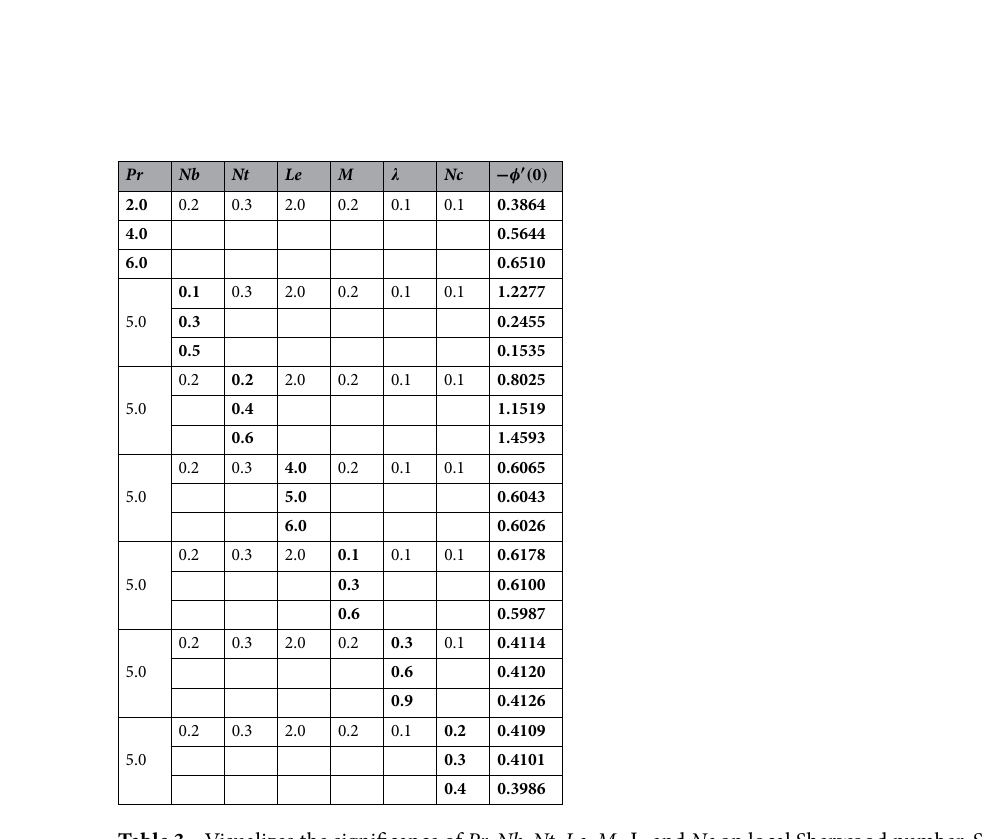
Table 3. Visualizes the significance of Pr, Nb, Nt, Le, M, ⅄ , and Nc on local Sherwood number. Significant values are in